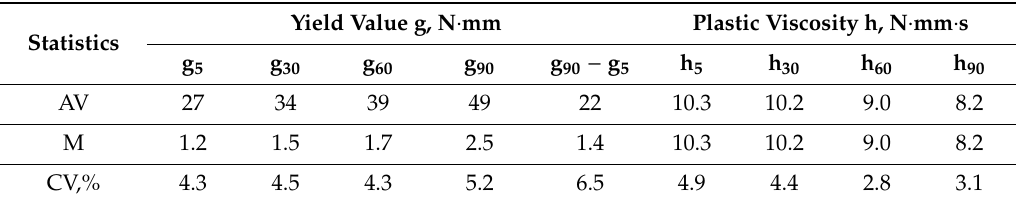
Rheological properties of reference mortar REF, AV—average value, M—median, CV—coe ffi cient of variation.